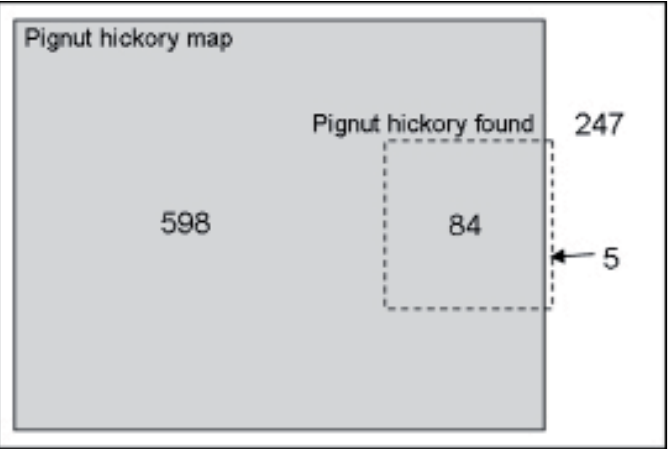
Figure 6. Venn diagram to demonstrate the predictive ability of the pignut hickory map. The large white rectangle symbo- lizes all sampled locations (n = 934), the smaller grey rectangle symbolizes the number of these locations that fell within the boundaries of the final habitat maps (n = 682), and the dashed rectangle symbolizes the number of sampled locations where pignut hickory was found (n = 89). The majority of the locations where pignut hickories were found fall within the boundaries of the final habitat